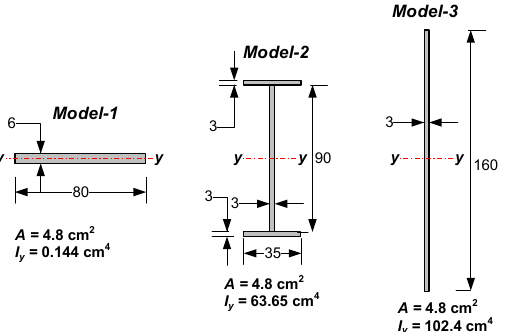
Figure 11. The ribbons’ cross-sections assumed for the parametric analysis.